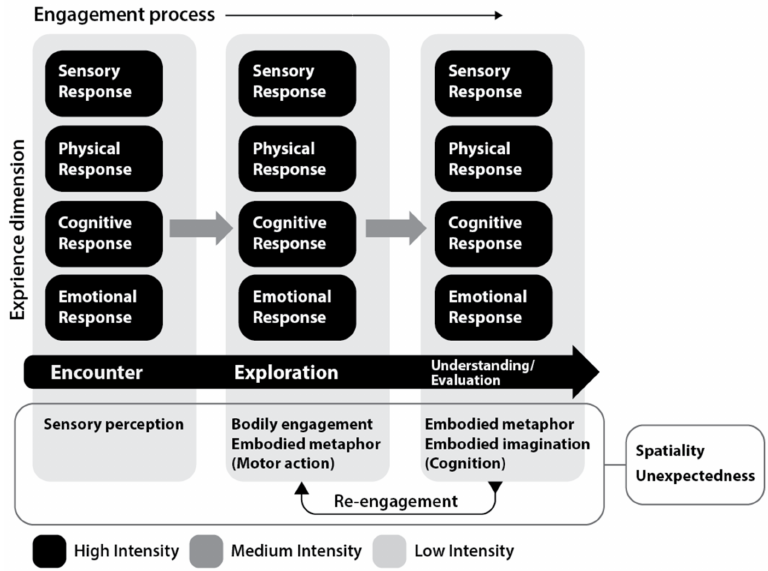
Figure 3. Unified embodied engagement